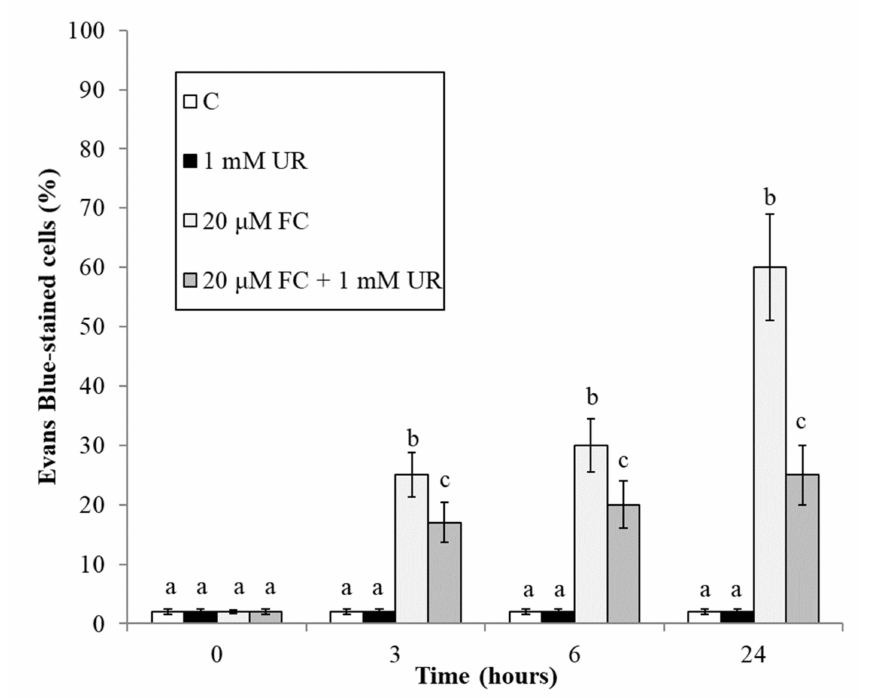
Figure 2. Effect of FC and urate on accumulation of dead cells in the cultures. Means ± SD (n ≥ 9) are shown. Different letters show significant differences among treatments at each time (Tukey HSD test, p ≤ 0.05).